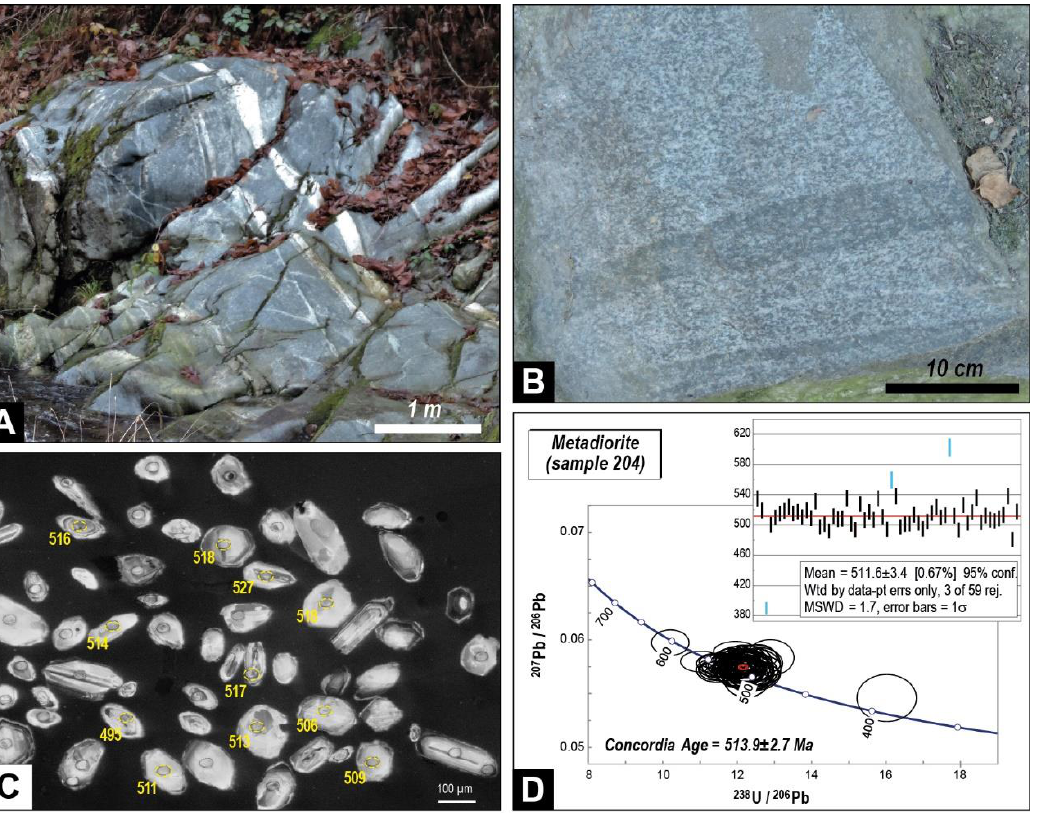
Figure 8. ( A ) View of the metadiorite with acidic dykes (N of Valmala); ( B ) close-up view of the outcrop of the metadiorite with a mafic enclave selected for U/Pb dating (ENE of Valmala); ( C ) CL image of some of the analyzed zircon grains (measured spots are shown by yellow circles with related ages); ( D ) concordia Tera–Wasserburg ( 207 Pb/ 206 Pb vs. 238 U/ 206 Pb) and weighted average ( 206 Pb/ 238 U ages) diagrams for analyzed zircons (sample 204).